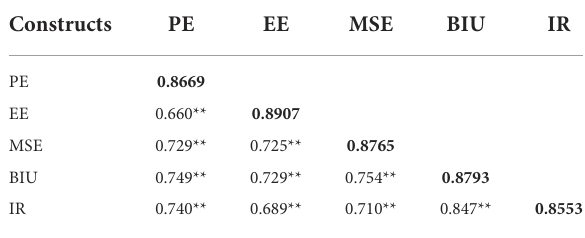
TABLE 5 Discriminant validity.